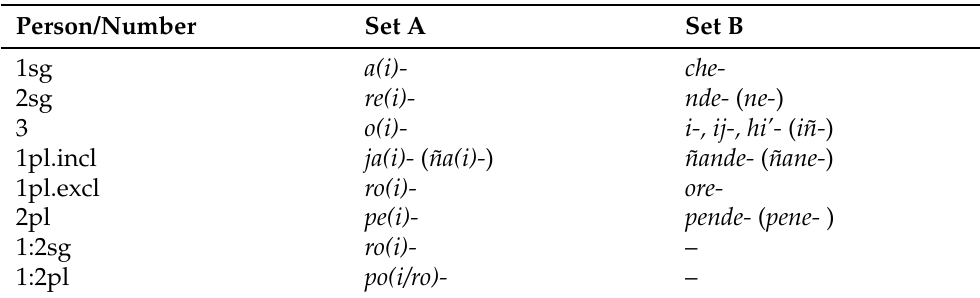
Table 1. Paraguayan Guaraní cross-reference markers, with nasal allomorphs in parentheses, adapted from (Estigarribia 2020, pp. 127f.,